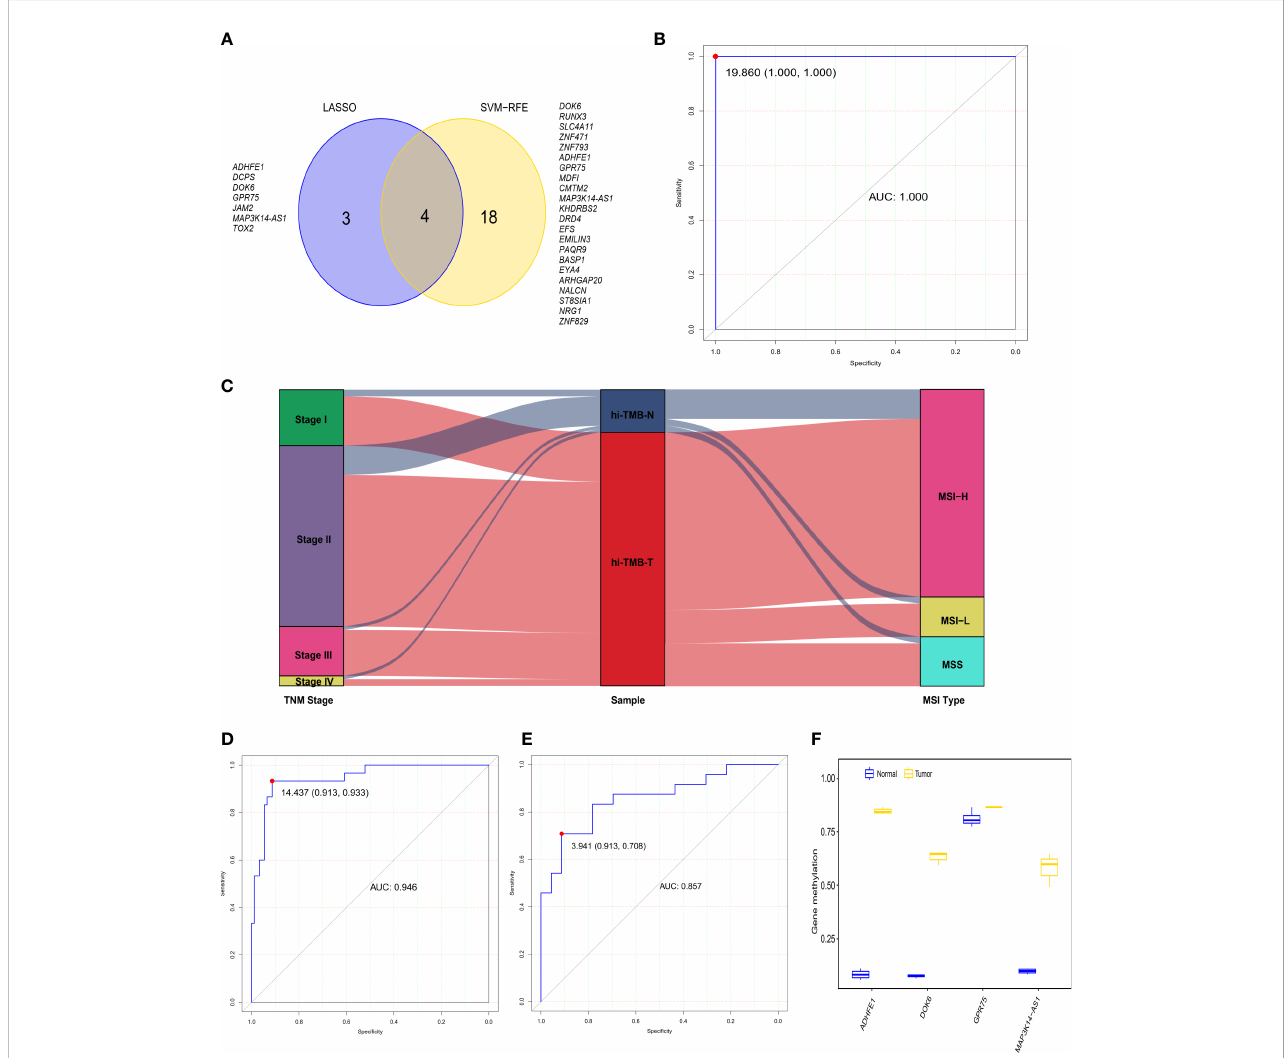
FIGURE 2 The diagnostic performance of the 4-gene methylation diagnostic score for colorectal tumor and adjacent normal tissues. (A) Screening of diagnostic markers via the Least absolute shrinkage and selection operator (LASSO) logistic regression algorithm and support vector machine-recursive feature elimination (SVM-RFE) algorithm of machine learning. (B) ROC curves of the diagnostic score constructed by the logistic regression model in the TCGA discovery set. (C) Alluvial diagram showing the changes of TNM stage, high TMB samples, and MSI type. (D, E) ROC curves of the diagnostic score validated in the GEO validation set A (D) and our in-house CRC validation set B (E) . (F) Methylation status of 4 genes in cell-free DNA samples from three colorectal cancer patients and four healthy controls in the GEO validation set